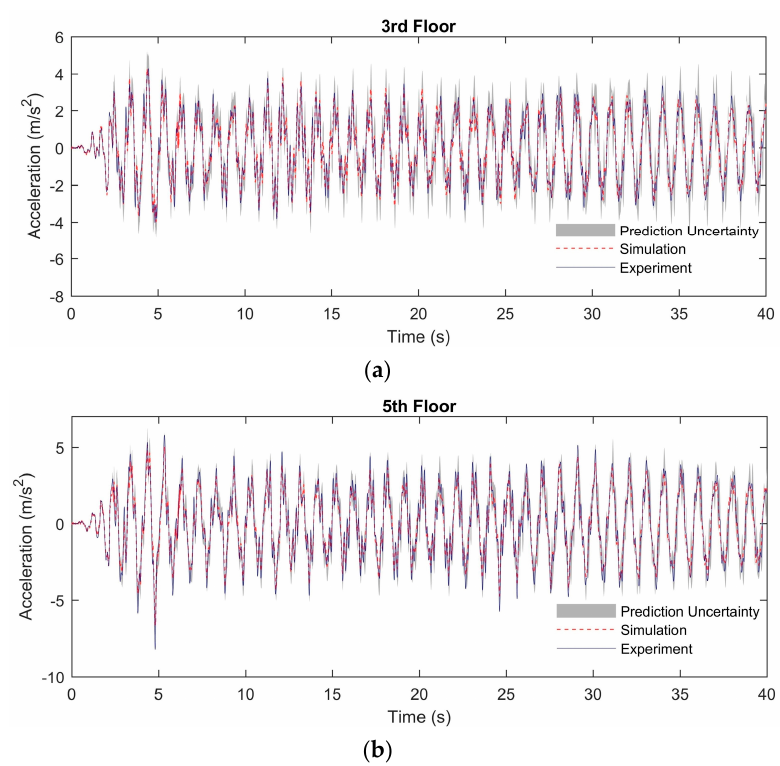
Figure 14. Experimental and simulation acceleration time histories in the linear structural system: ( a ) At the 3rd floor; ( b ) At the 5th